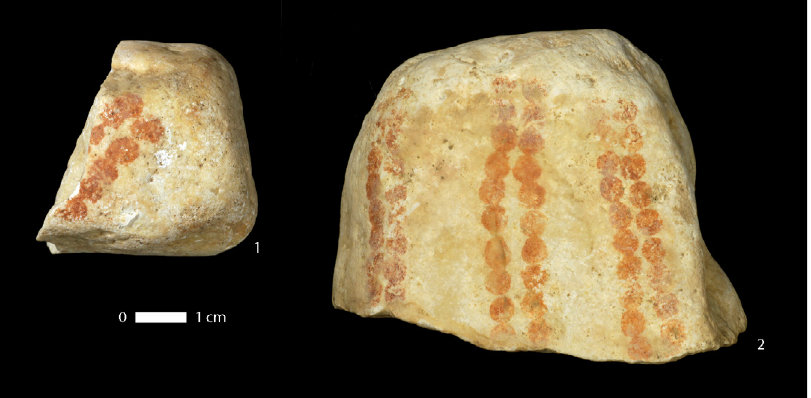
Figure 6. Hohle Fels, painted limestones, excavated 2010. Photo: M.